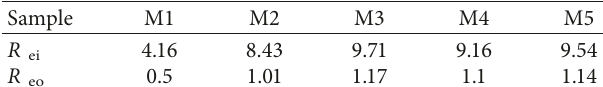
Table 2: Initial Reynolds